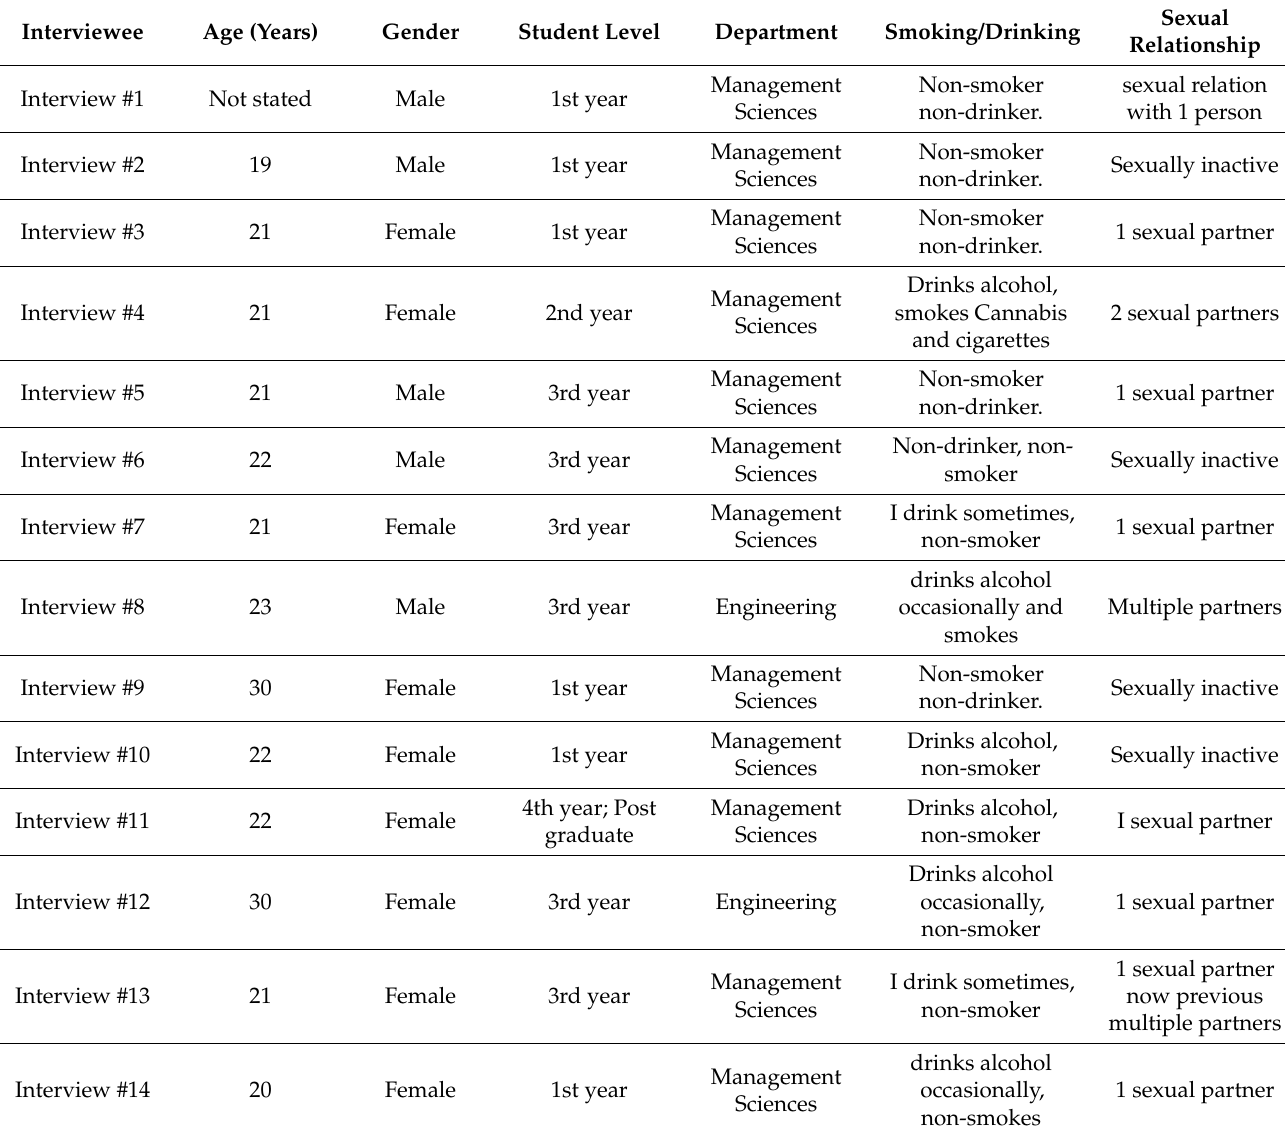
Table A1. Describing the demographic distribution on study